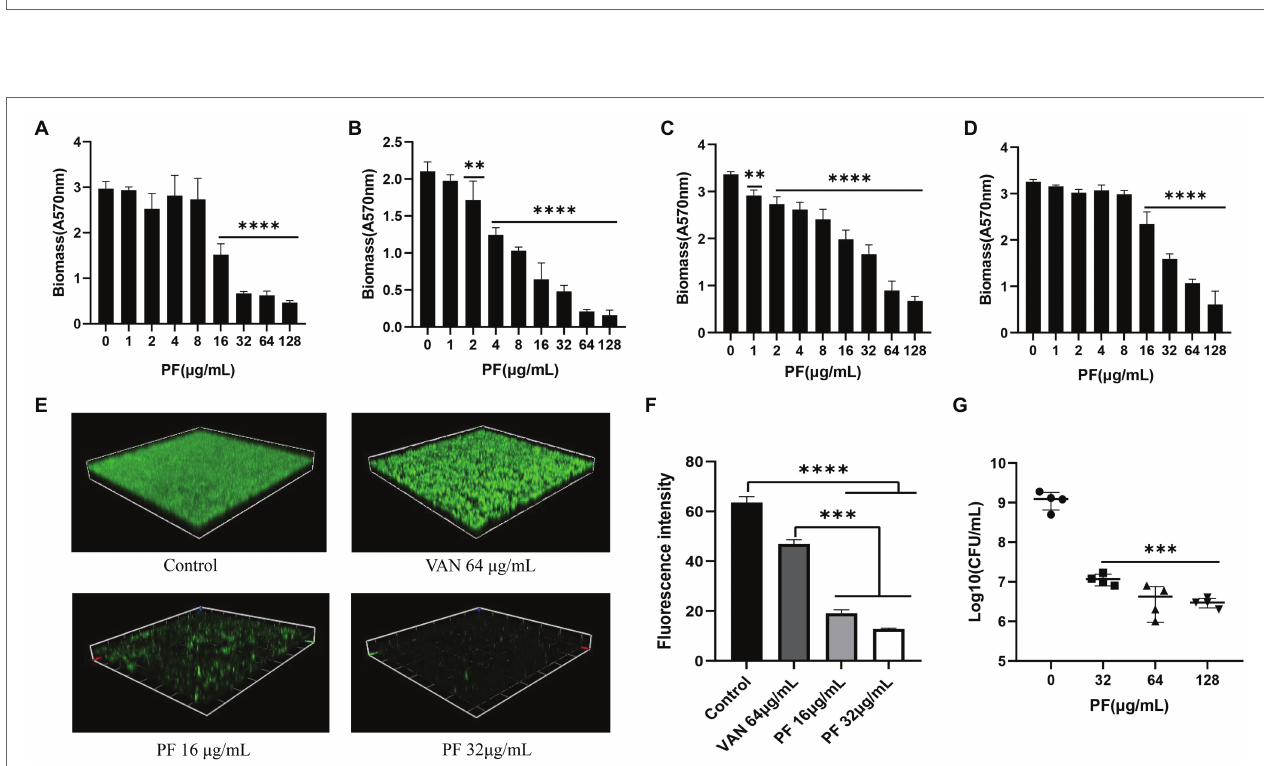
FIGURE 2 | Biofilm eradication effect of PF against S. aureus . Biofilm-eradicating effects of PF against four strong biofilm producers (A) ATCC 43300 (B) USA 300 (C) SA 1901, and (D) LZB1, was measured by the crystal violet staining. (E) Confocal laser scanning microscope observation (CLSM) images (Scale bars, 40 μ m) and (F) fluorescence intensity quantification analysis of biofilm-eradicating effect of PF against S. aureus ATCC 43300, by ImageJ software. (G) Live cells in biofilm of S. aureus ATCC 43300 were counted by colony counting method. Results were presented as mean ± SD. ** p < 0.01; *** p < 0.001; **** p <